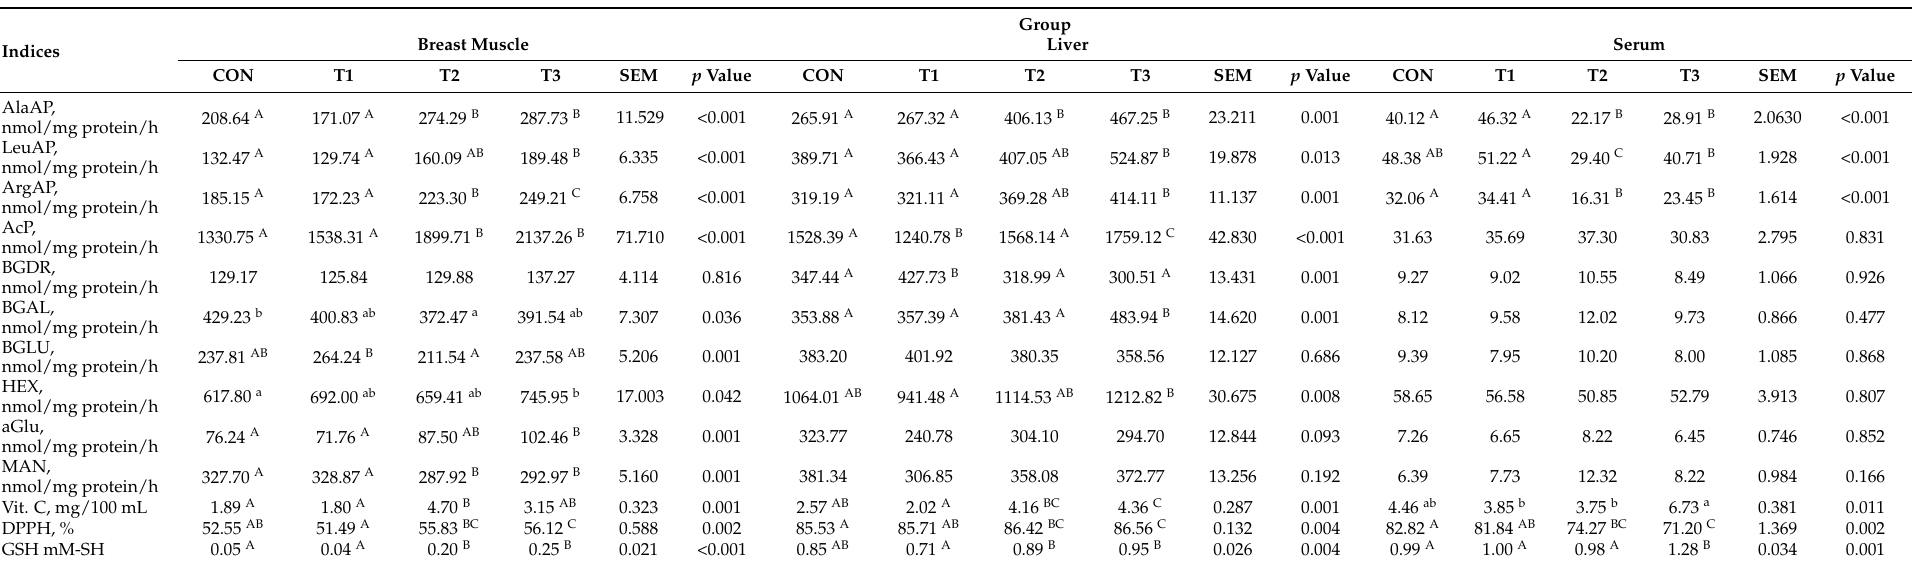
Table 5. Enzymatic activity and antioxidant potential in selected tissues of male broiler